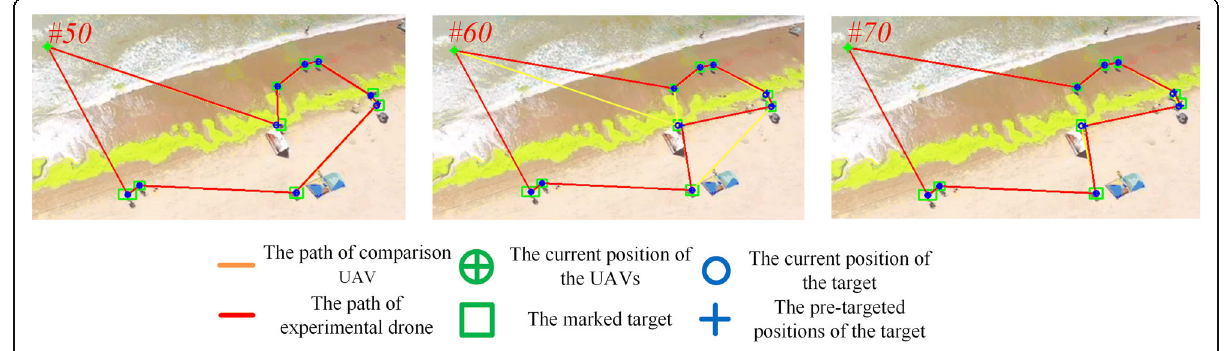
Fig. 8 The experimental results of the simulation of the path planning of multiple